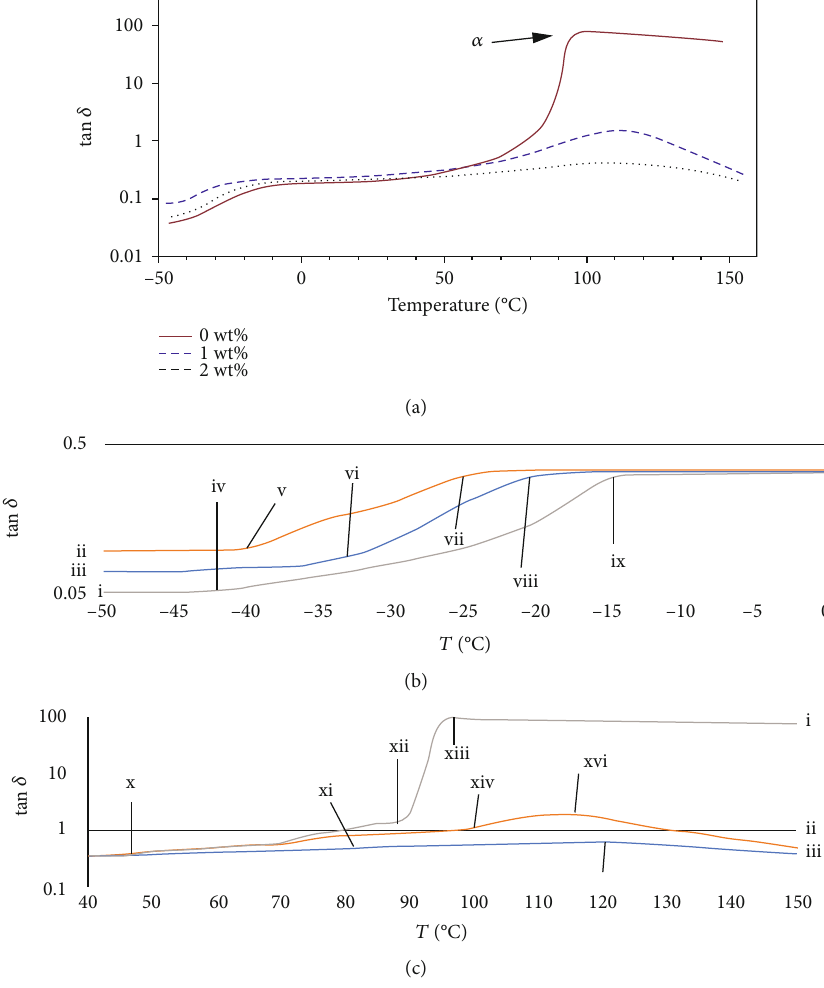
Figure 18: (a) The e ff ect the introduction of graphene has upon an epoxy ester-siloxane-urea polymer system. (b) A closer view of the fi rst T g curve. (c) A closer view of the second T curve. For (b) and (c), (i) is 0wt% graphene added to the polymer system, (ii) is the e ff ect when 1wt% g graphene is added to the polymer system, and (iii) is the e ff ect of 2wt% graphene being added to the polymer system. (iv), (x), and (xii) are possible T points for the polymer system with no graphene added. (x), (v), and (xiv) are possible T points for the polymer system with 1wt% g g points for the polymer system with 2 wt% graphene added. (ix) and (xii) are local tan δ maxima graphene added. (x) and (vi) are possible T g for the polymer system with no graphene added. (vi) and (xvi) are local tan δ maxima for the polymer system with 1 wt% graphene added. (viii) and (xv) are local tan δ maxima for the polymer system with 2 wt% graphene added